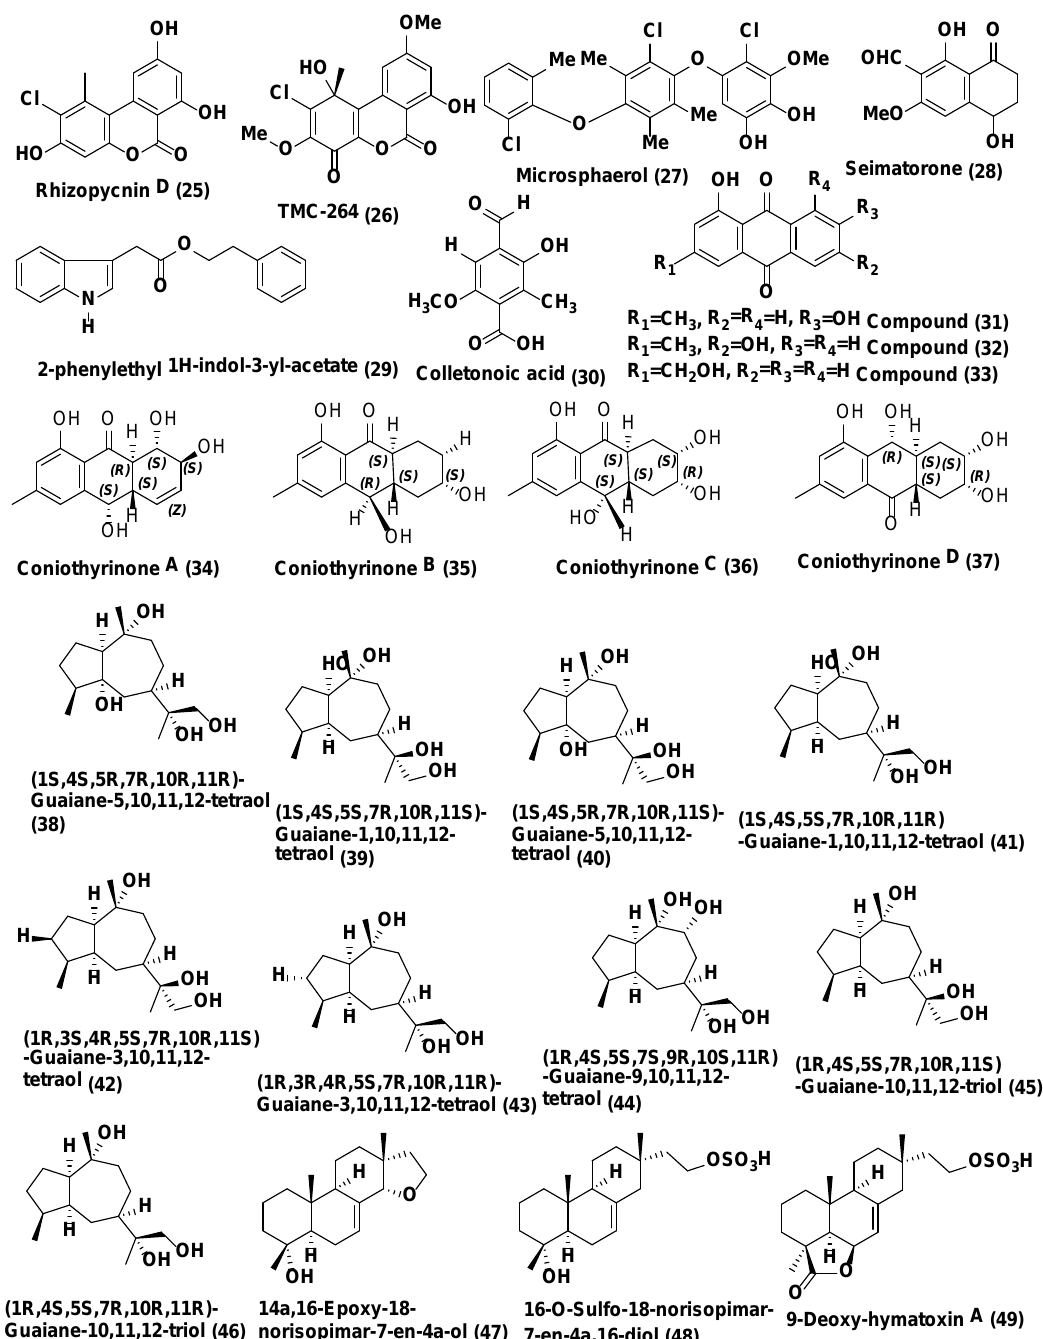
Figure 2. Structures of metabolites isolated from Coelomycetes ( 25 – 37 ) and Ascomycetes ( 38 – 49 ).